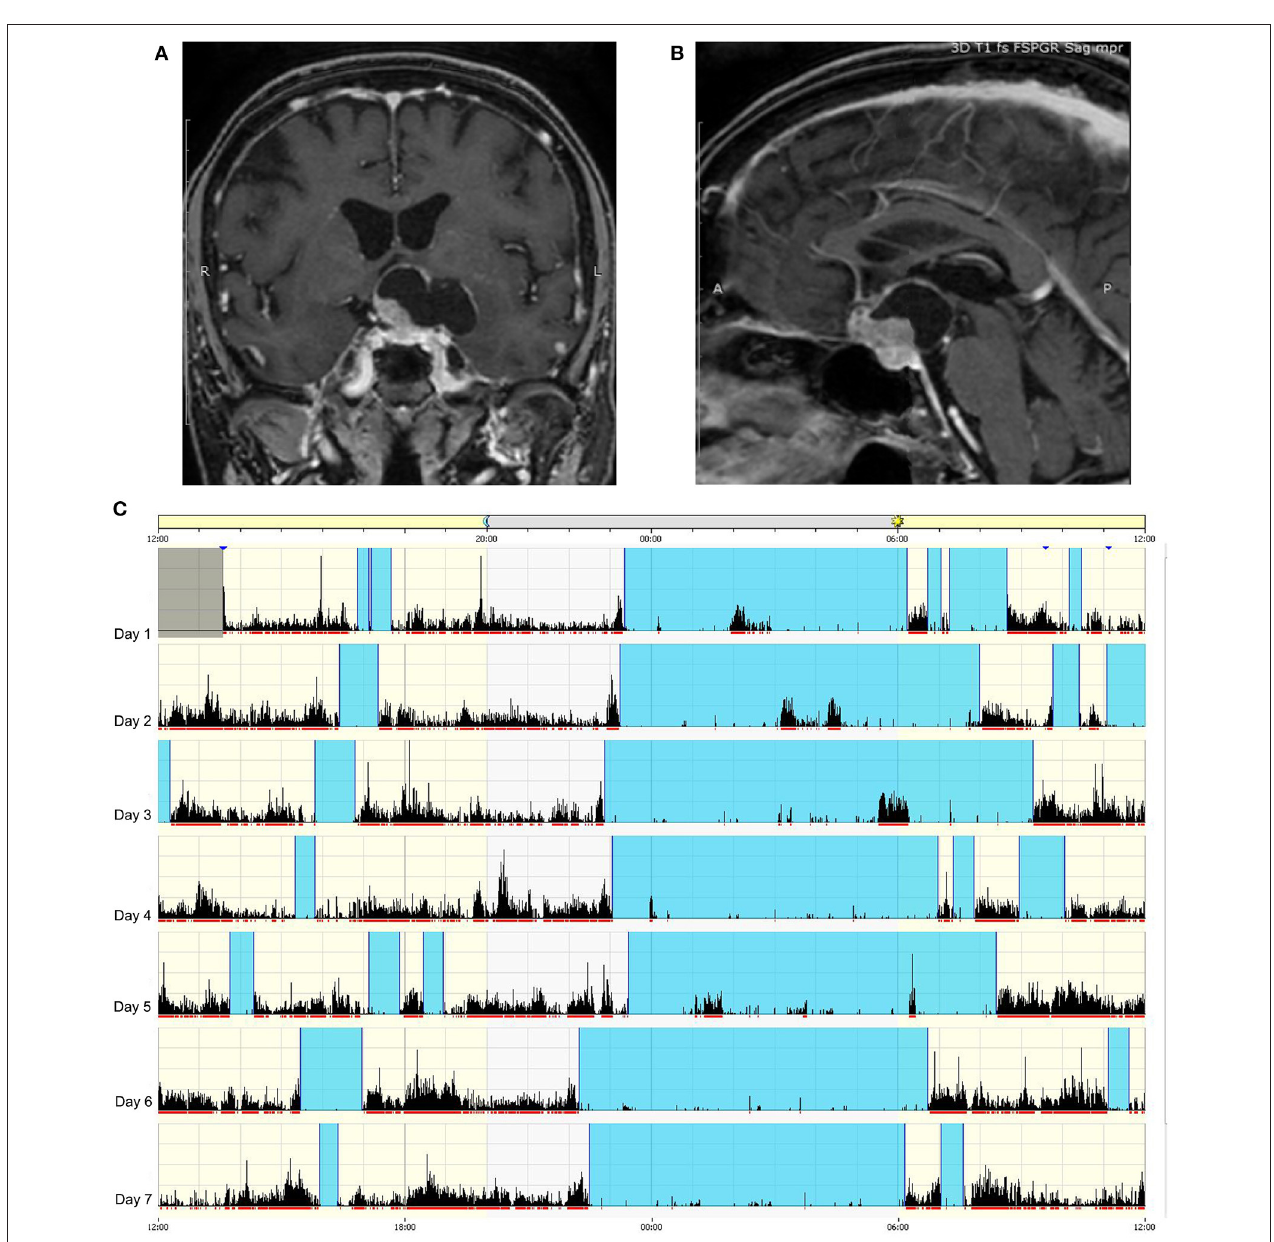
FIGURE 5 | Example of circadian sleep-wake alteration evaluation by actigraphy. A 75-year-old female patient came to our observation because of headache and visual loss in the context of recent and rapidly worsening neurological symptoms consisting of insomnia, excessive daytime somnolence, cognitive impairment, reduced appetite, and weight loss. No poliurodyspia was present, and basal pituitary function and electrolytes were normal. Contrast-enhanced T1-weighted MRI revealed a mixed cystic and solid tumor consistent with suprasellar craniopharyngioma (A) with retrosellar extension (B) . Sleep-wake patterns are displayed for individual days on actigraphy (C) : vertical black bars and the red line under each day indicate movement, and the absence of black bars indicates supposed sleeping periods. The blue band designates the sleep period. The actigram shows frequent nighttime activity, severe insomnia, sleep fragmentation, and frequent short diurnal naps. The patient is currently awaiting